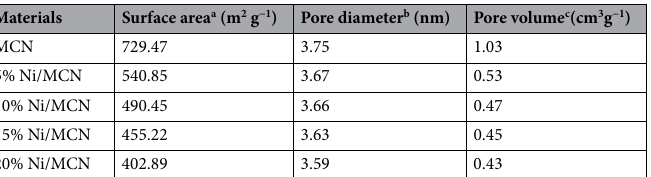
Table 1. Textural property of the synthesized catalysts. a Determined from BET equation. b BJH desorption average pore diameter. c BJH desorption pore